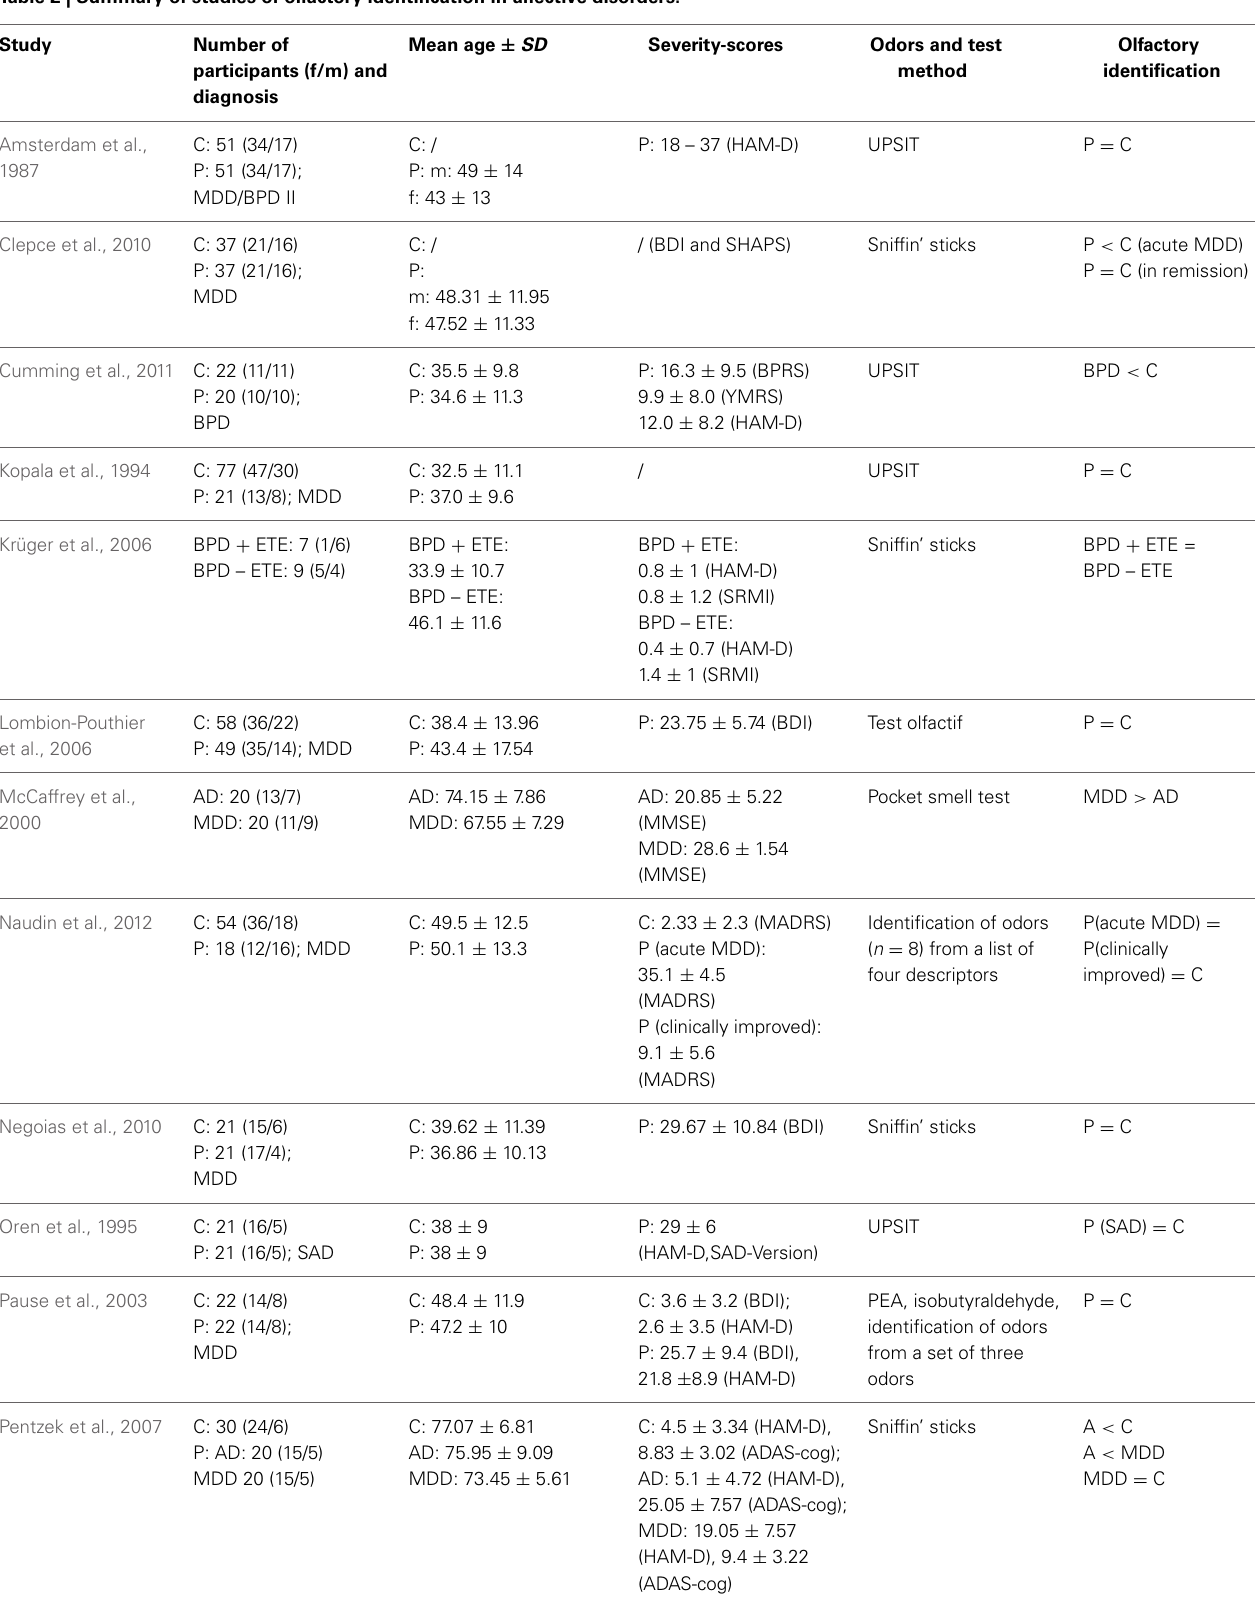
Table 2 | Summary of studies of olfactory identification in affective